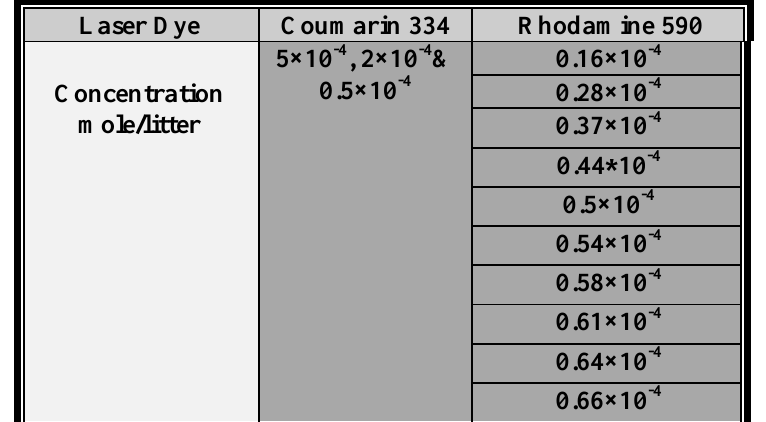
Table 1: The molar concentration of the mixing prepared dye